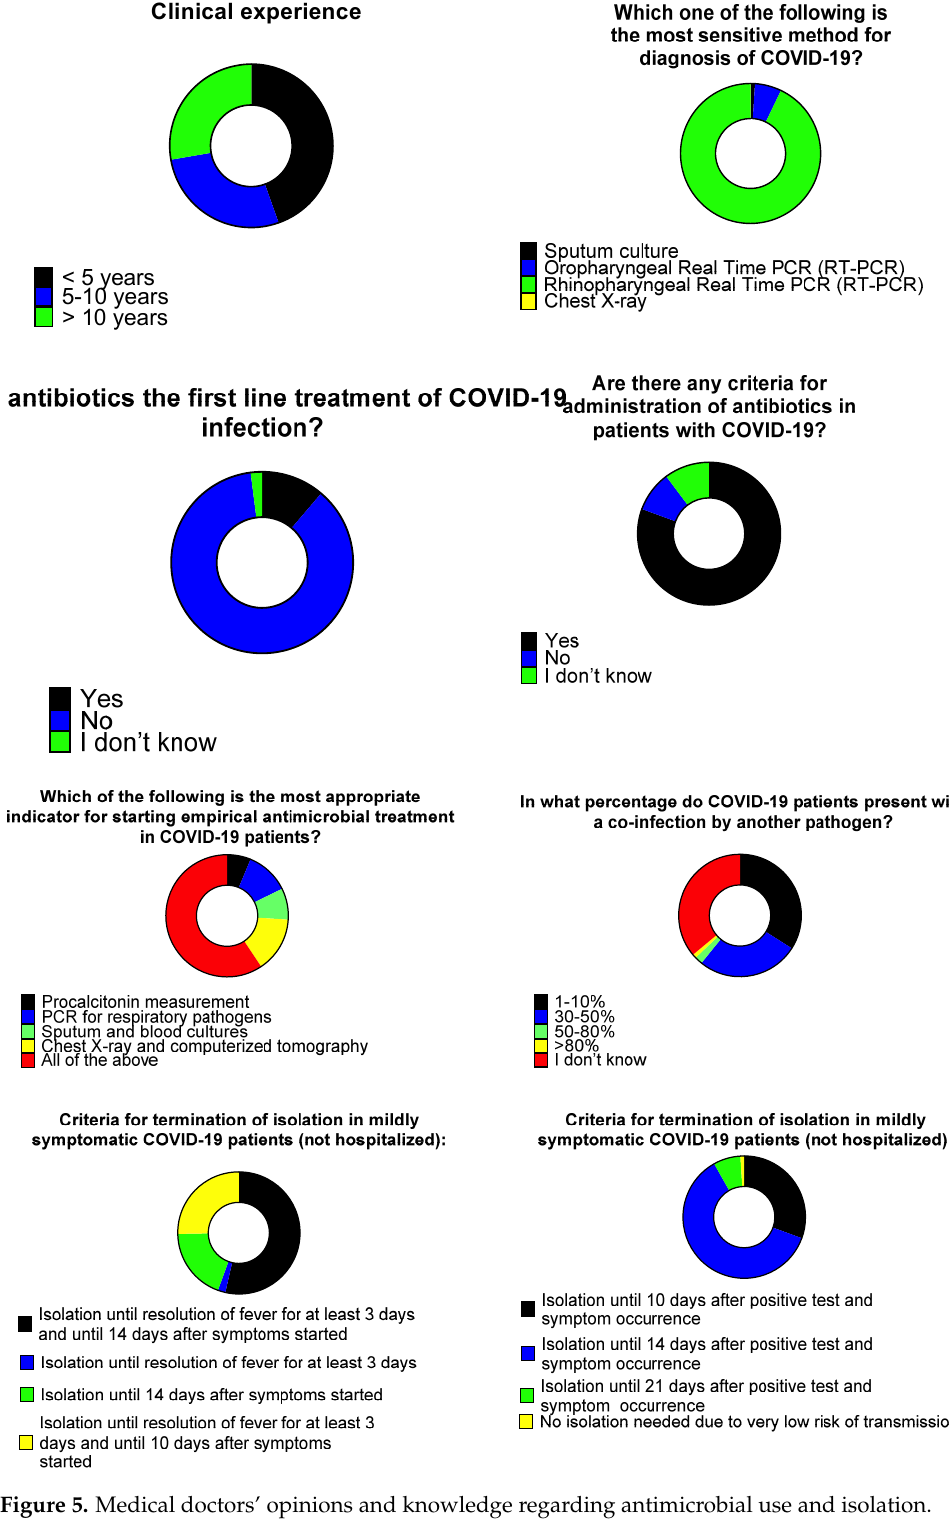
Figure 5. Medical doctors’ opinions and knowledge regarding antimicrobial use and isolation.